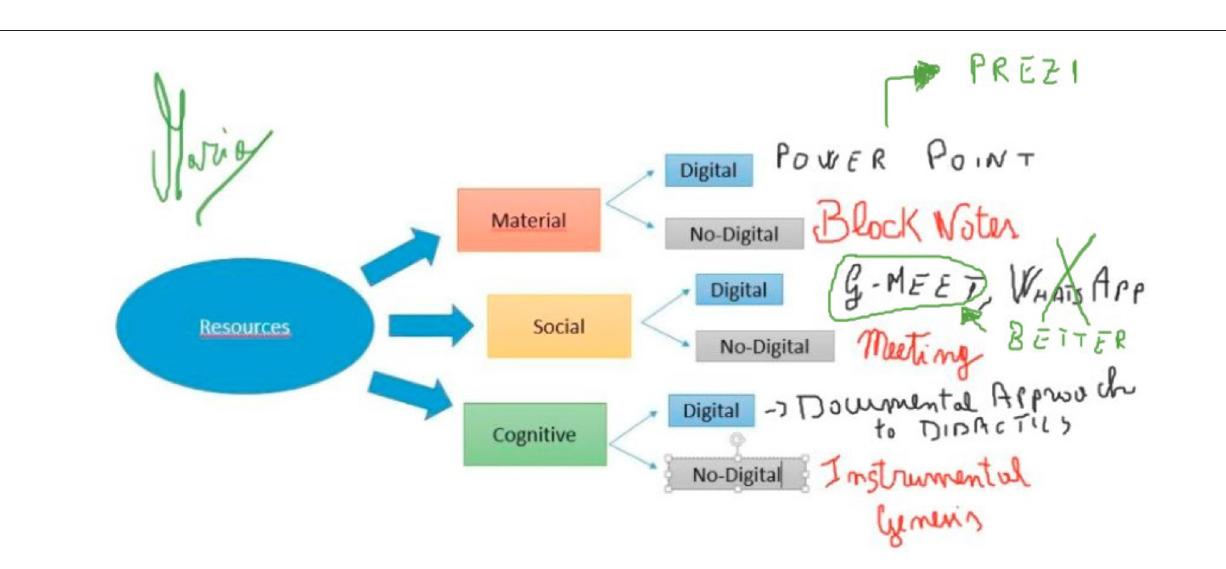
- Web resources to collect data (Youtube, Online Newspapers, TV on